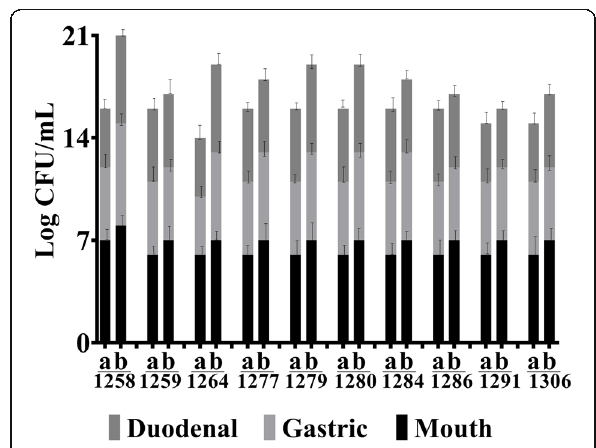
Fig. 3 In vitro digestion assay of the selected Lactobacilli without ( a ) and with ( b ) food matrix. 1258: L. plantarum , 1259: L. plantarum, 1264: P. pentosaceus , 1277: L. plantarum , 1280: L. plantarum , 1284: L. plantarum, 1286: L. plantarum, 1291: P. pentosaceus , 1301: L. plantarum . Results are means of three independent experiments with three repetitions ± SD, n =